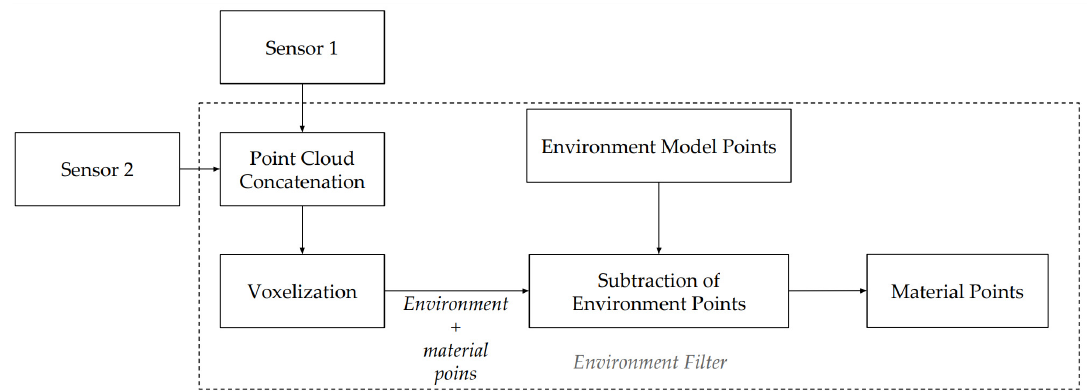
Figure 6. Processes to obtain the Point Cloud of the material.